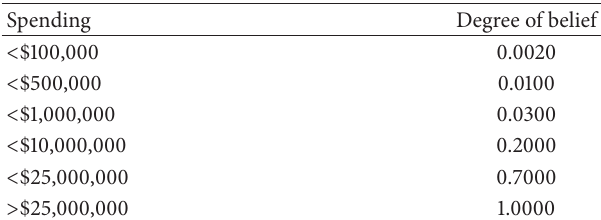
Table 1: Respondent belief associated with